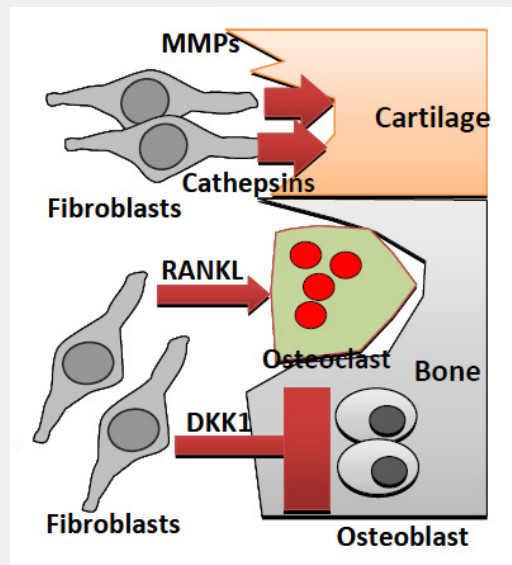
Fibroblasts orchestrate chronic inflammation in RA. The maintenance of persistent leukocyte infiltrates results from a distorted homeostatic balance between leukocyte recruitment, proliferation, emigration and death. Activated RASFs produce inflammatory chemokines (IL-8, CXCL5, CXCL1) implicated in leukocyte recruitment to diseased synovium, survival factors (type I interferon, IL-15, BAFF) and constitutive chemokines (e.g. CXCL12, CCL21). The net result is the chronic accumulation, survival and retention of leukocytes at sites of disease.